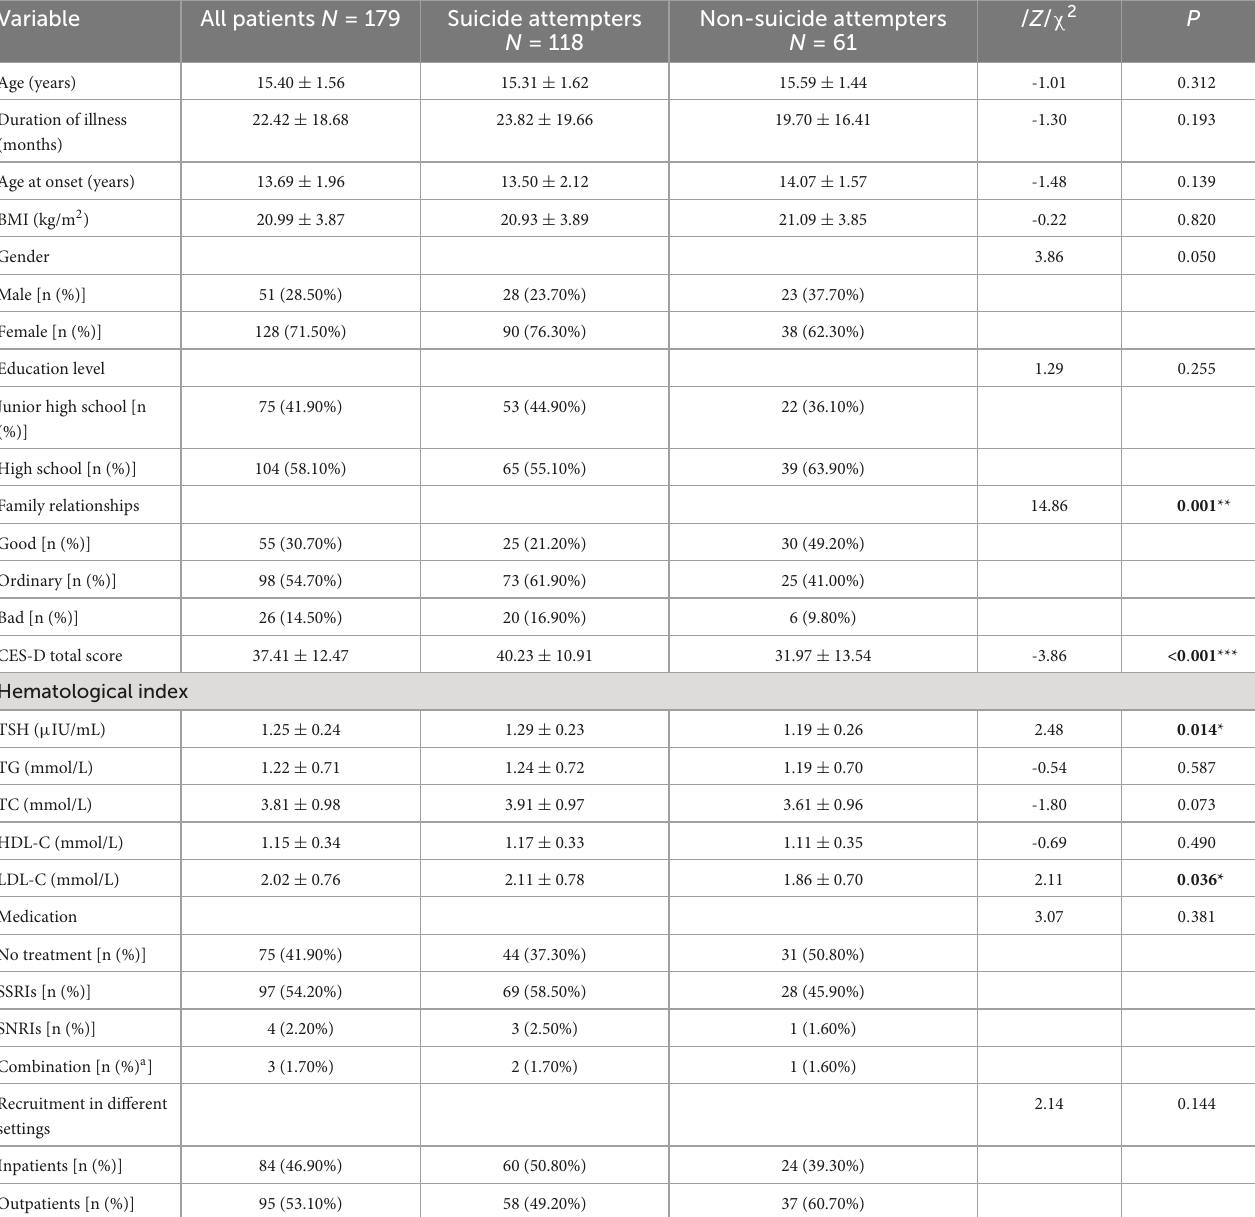
TABLE 1 Socio-demographics and clinical characteristics of adolescent patients between suicide attempters and non-suicide attempters.